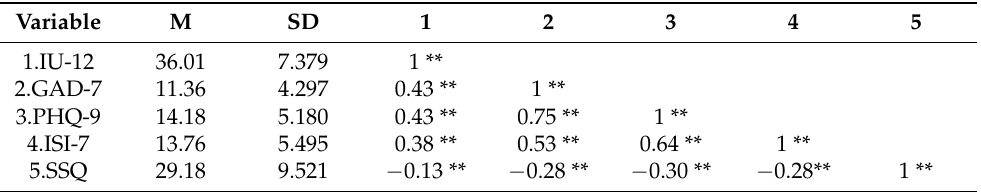
Table 2. Descriptive Statistics and Pearson’s Correlations among Variables.